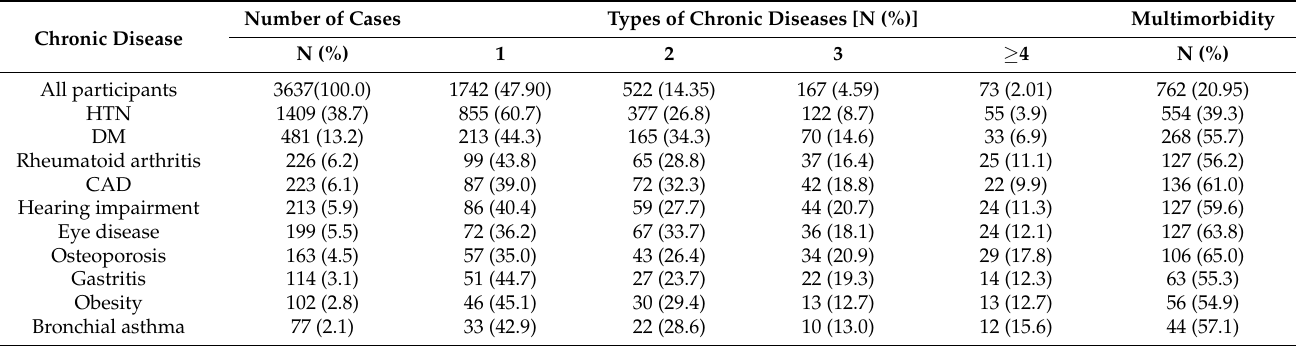
Table 1. Prevalence of ten most prevalent chronic diseases and multimorbidity among older